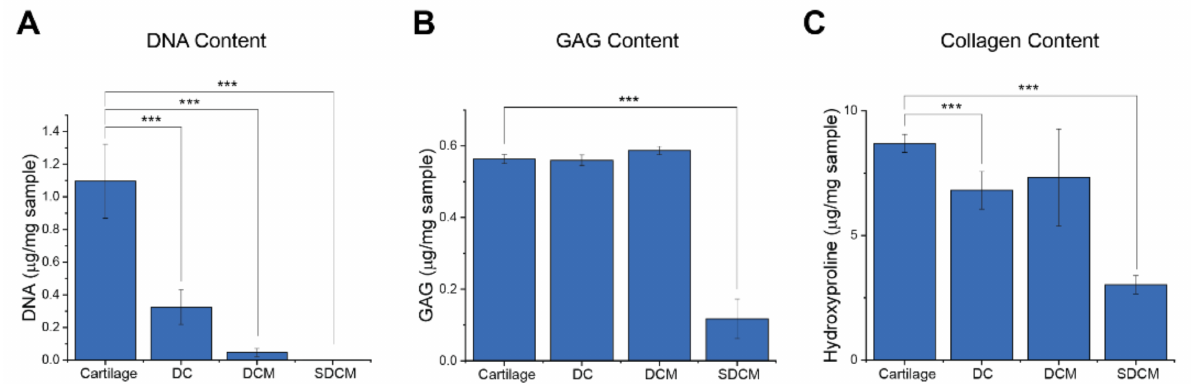
Figure 2. Analysis of key biomolecules during the divitalization process of the processed extracellular matrix (ECM). ( A ) DNA content; ( B ) glycosaminoglycans (GAG) content; and ( C ) collagen content of lyophilized cartilage, devitalized cartilage (DC), decellularized cartilage matrix (DCM), and solubilized decellularized cartilage matrix (SDCM) (Data presented as mean ± SD; *** p < 0.001; n =